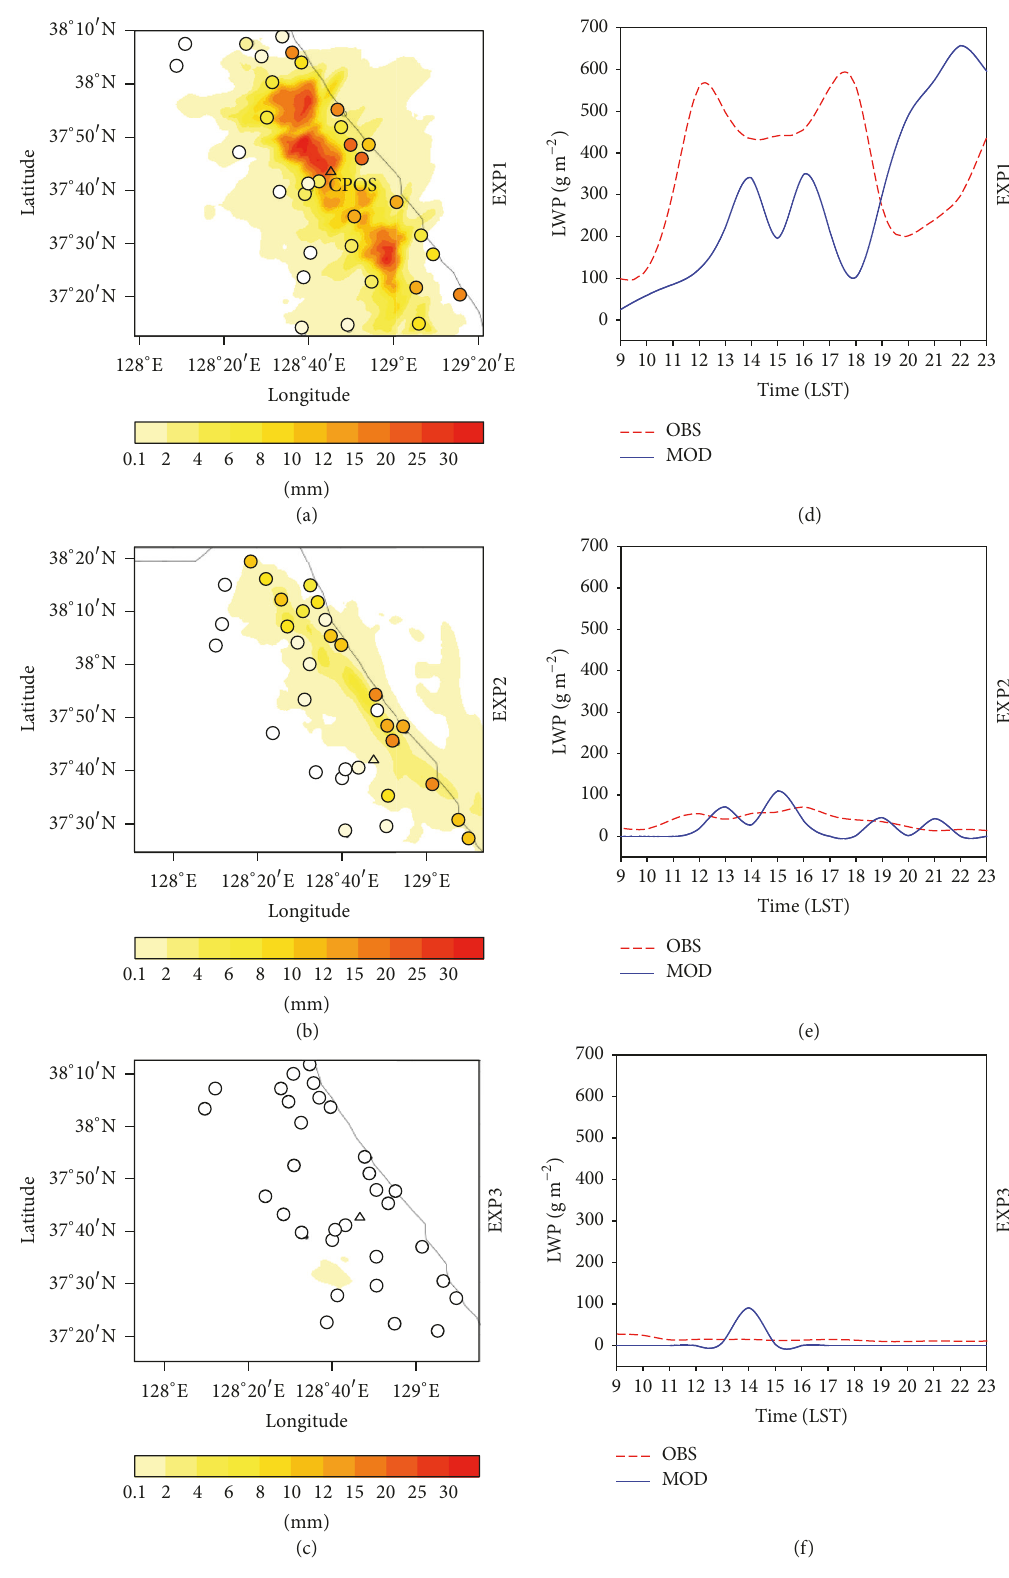
Figure 3: (a, b, c) The 18-hour accumulated precipitation (mm) of the NOSEED simulations and AWS rain gauges that include a heating device to melt snow in (a) EXP1, (b) EXP2, and (c) EXP3. The model precipitation is color-shaded and is overlaid with the AWS precipitation in the color-filled circles. (d), (e), and (f) indicate the time series of the 1-hour averaged LWP from the radiometer (OBS) and NOSEED simulations (MOD) at